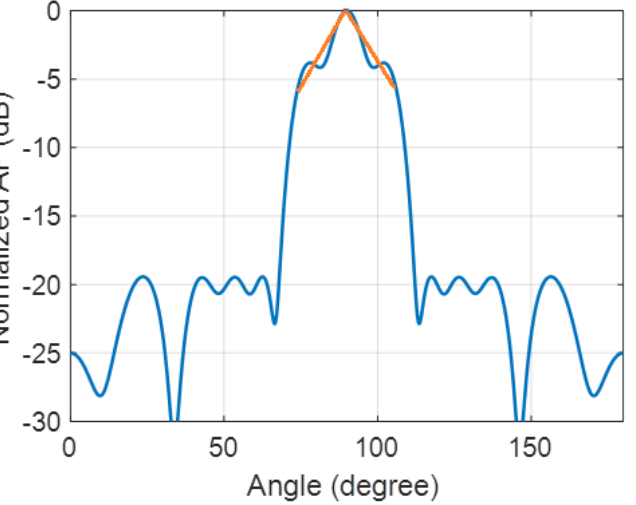
Figure 9. The normalized triangular array factor for 20 element array antenna by modifying the inter-element spacing of the array antenna using FKE algorithm. inter-element spacing of the array antenna using FKE